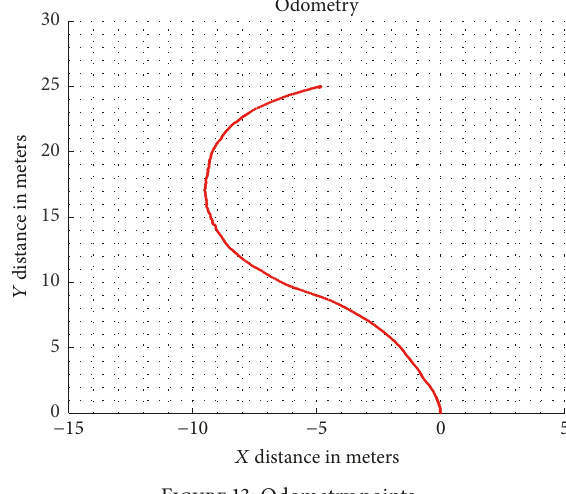
Figure 11: Global path.